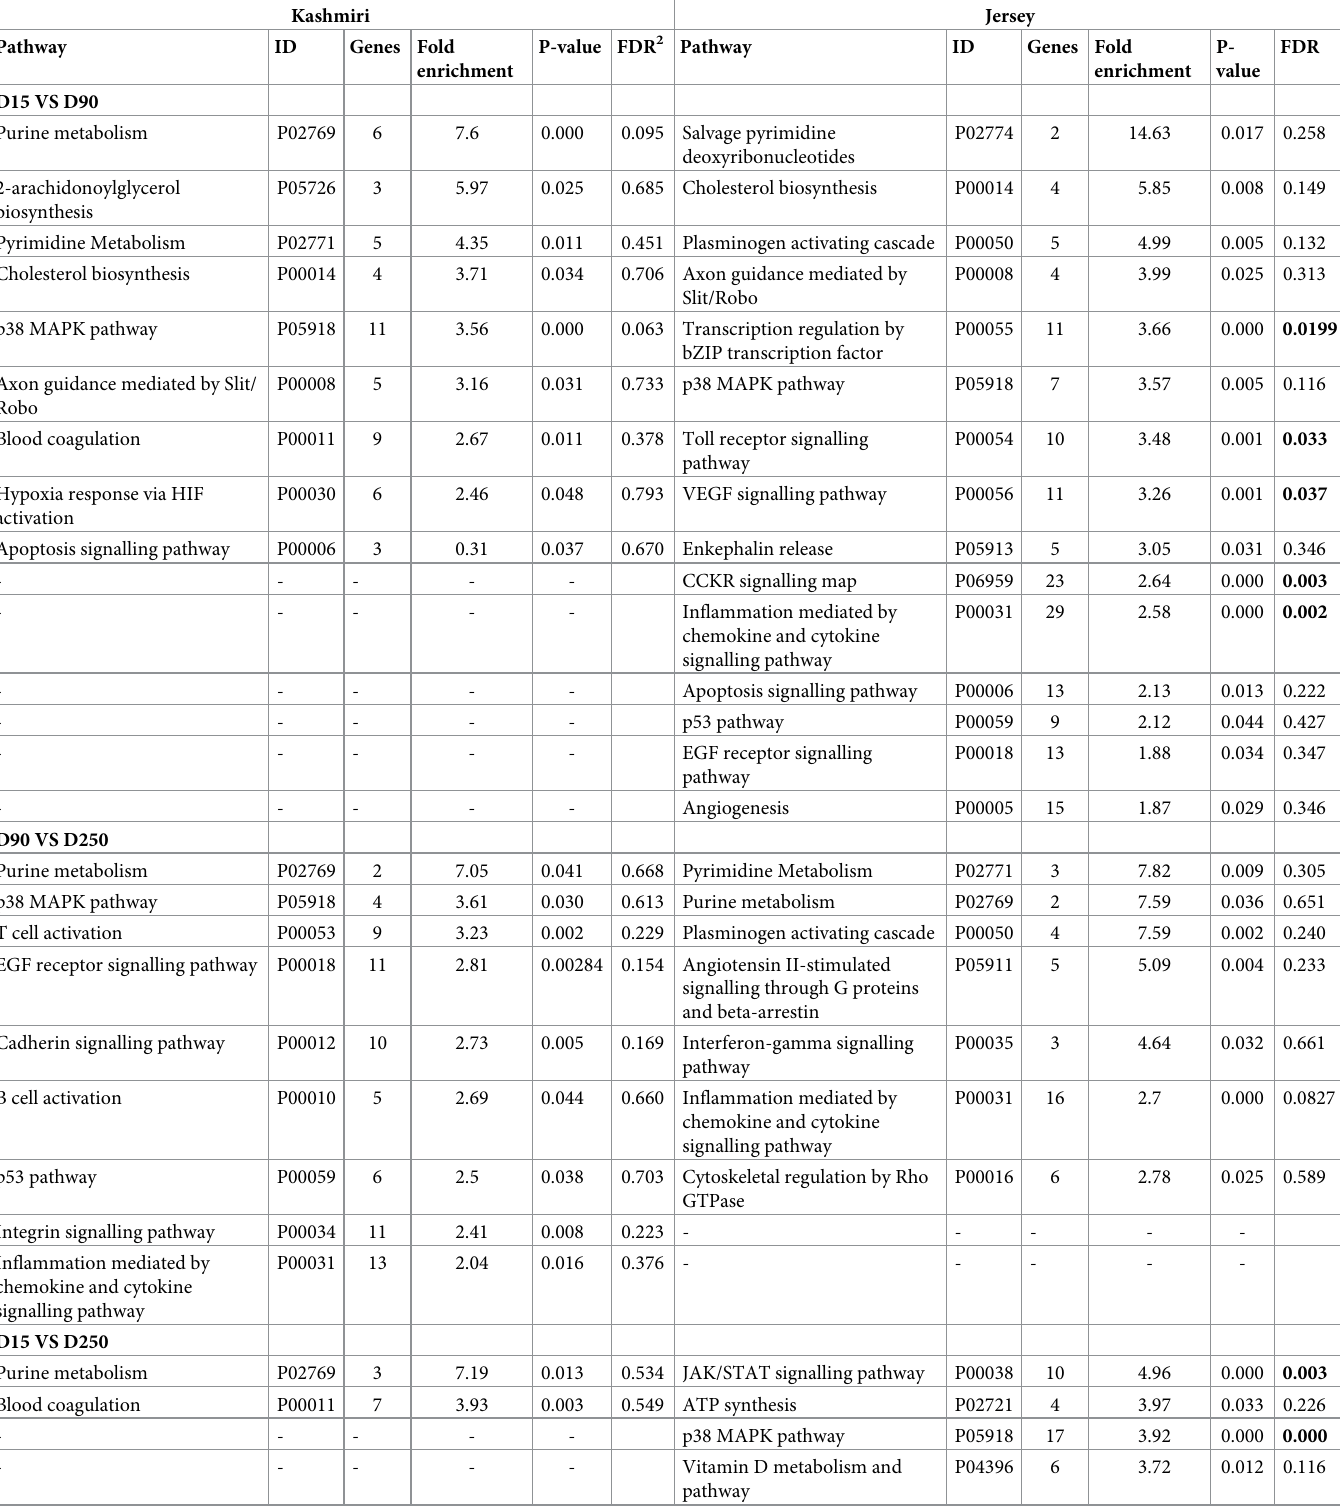
P- enrichment value